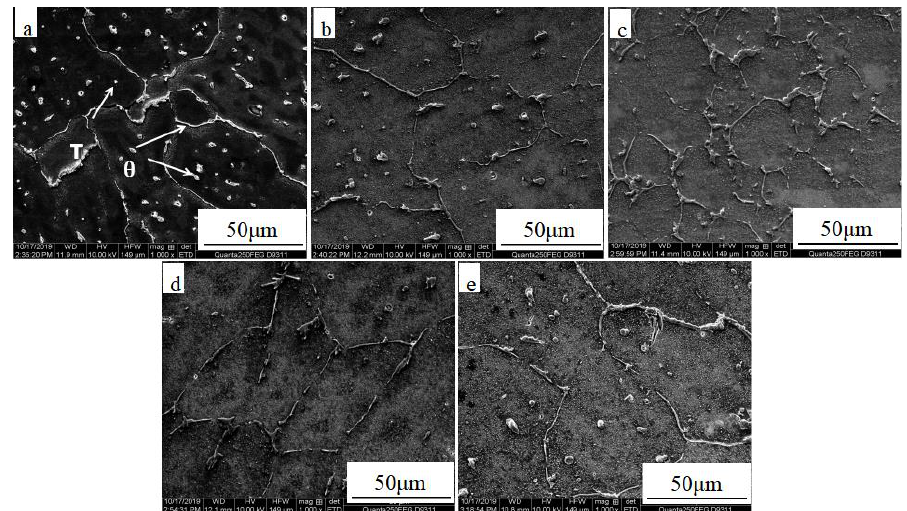
Figure 5. SEM of deposits with different heat input in as-deposited state. ( a ) 30 J/mm; ( b ) 60 J/mm; ( c ) 90 J/mm; ( d ) 120 J/mm; ( e ) 150 J/mm.